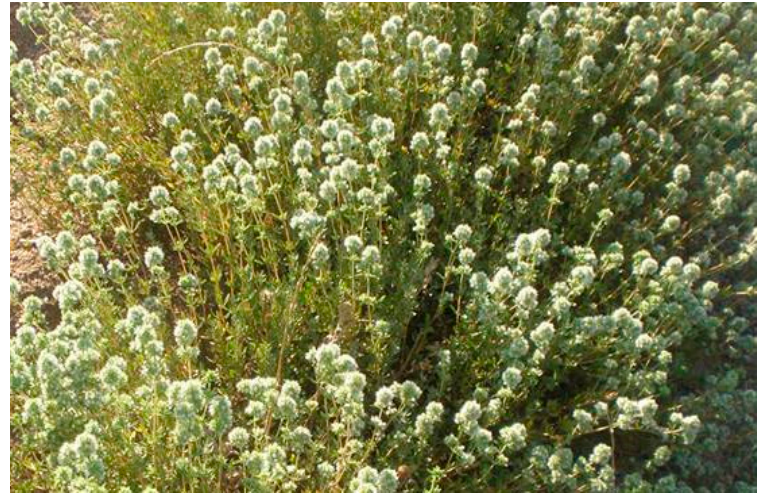
Figure 1. Thymus mastichina plant (source Planalto Dourado TM Essential Oils Enterprise, from Freixedas, Guarda, Portugal).